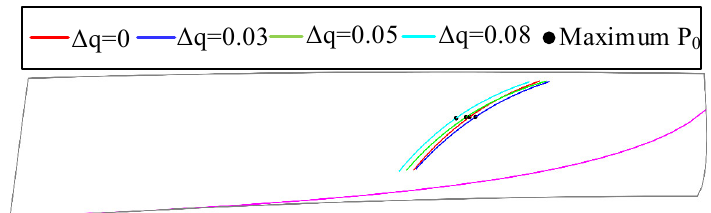
Table 13. Optimization results for different values of pinion-offset error △ E .